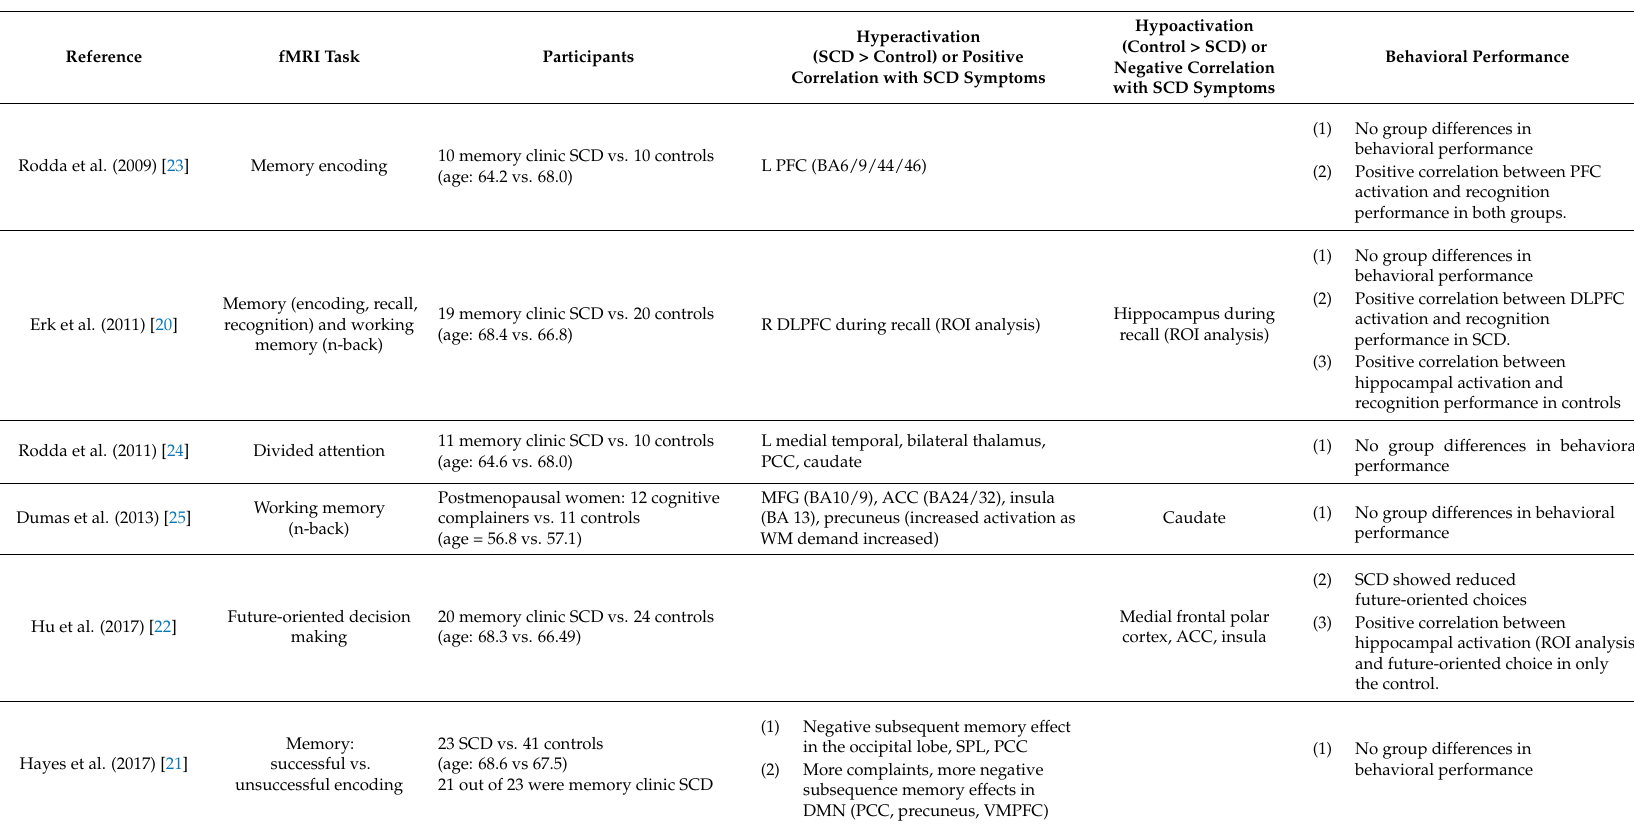
Table 1. Summary of fMRI studies in SCD. Most of these studies demonstrate a pattern of regional hypoactivation, associated with hyperactivation elsewhere. This hyperactivation has been interpreted by authors as a compensatory response to the hypoactivation. Abbreviations: SCD: subjective cognitive decline, PFC: prefrontal cortex, BA: Brodmann area, DLPFC: dorsolateral prefrontal cortex, ROI: region-of-interest, SPL: superior parietal lobe, PCC: posterior cingulate